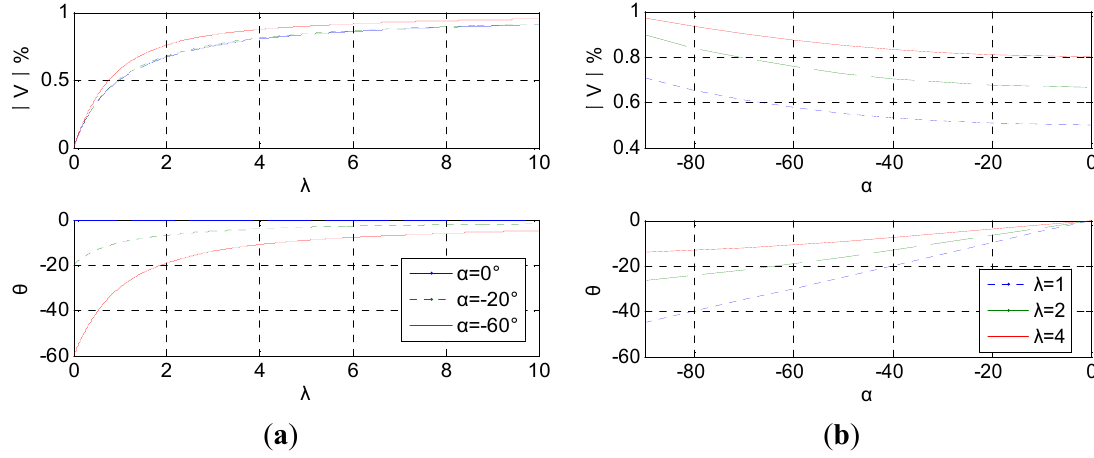
Figure 2. Magnitude and phase-angel jump under grid fault Type A. ( a ) α is fixed; ( b ) λ is